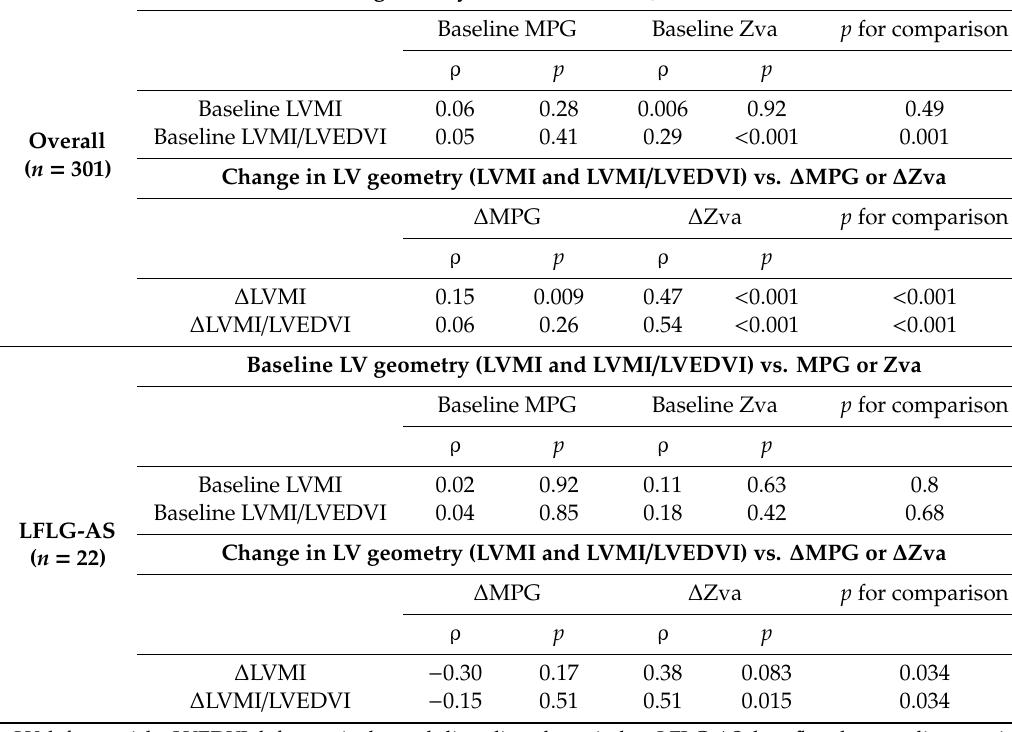
Table 3. The relationship between MPG or Zva and LV geometry (LVMI and LVMI / LVEDVI) at baseline and change after